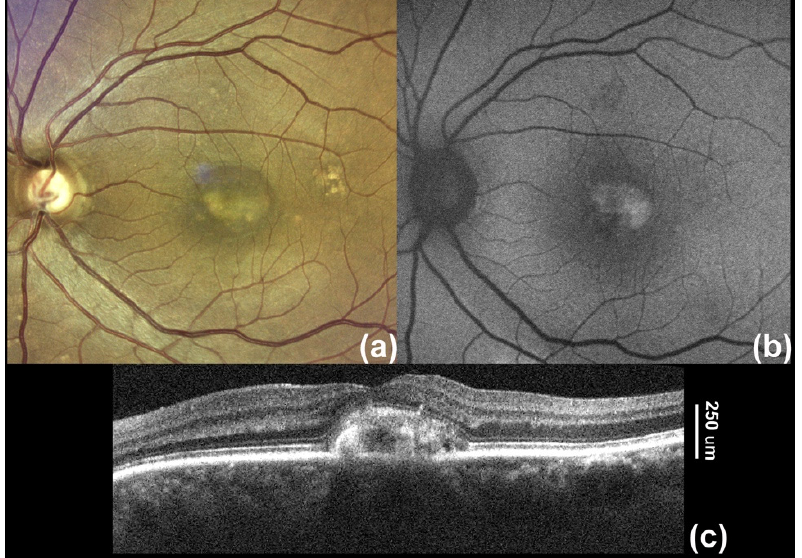
Figure 1. Multimodal imaging in adult-onset foveomacular vitelliform dystrophy. ( a ) True color confocal fundus photograph (Compass, Centervue, Padova, Italy) shows a central roundish yellowish lesion. ( b ) Fundus autofluorescence (Spectralis HRA, Heidelberg Engineering, Germany) demon- strates hyperautofluorescent signal corresponding to the vitelliform lesion. ( c ) Spectral-domain optical coherence tomography b-scan obtained in the subfoveal region shows an accumulation of subretinal hyperreflective material with a dome-shaped configuration (Angiovue, Optovue, Inc, Fremont, CA,